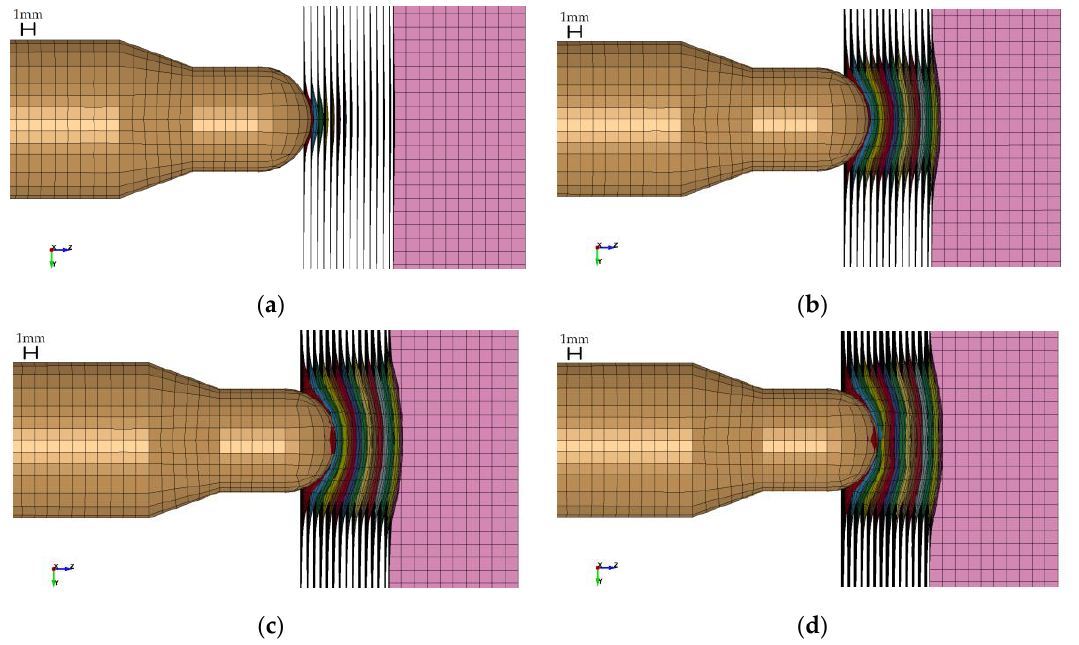
Figure A4. Damage caused by the hemispherical striker at different instances of the simulation: ( a ) time = 0.05 ms, ( b ) time = 0.1 ms, ( c ) time = 0.15 ms, ( d ) time = 0.2 ms.